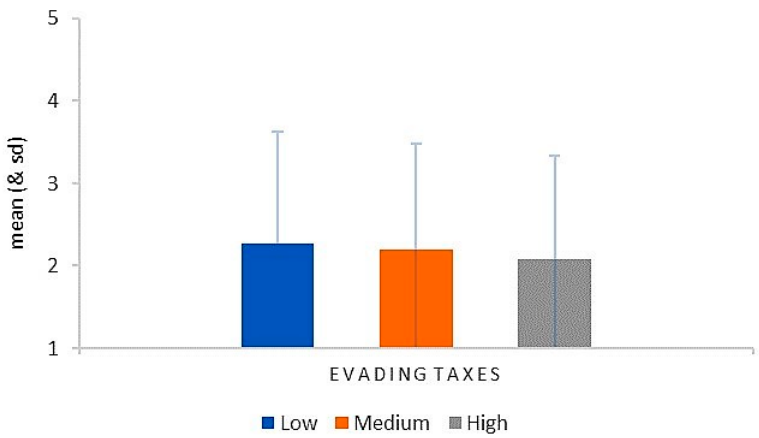
Figure 15. Evading taxes by the level of religiosity. (The error bars represent standard deviation).